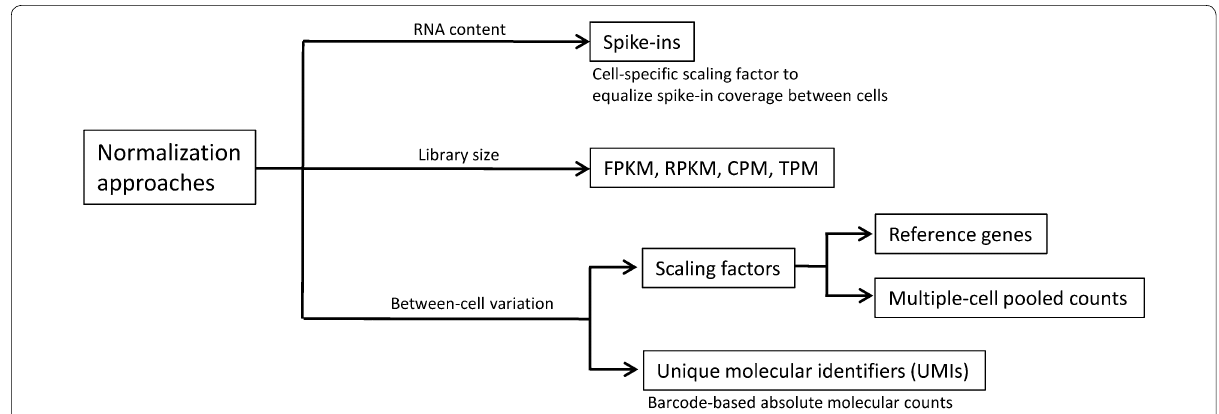
Fig. 4 Normalization approaches commonly used in scRNA‑seq data